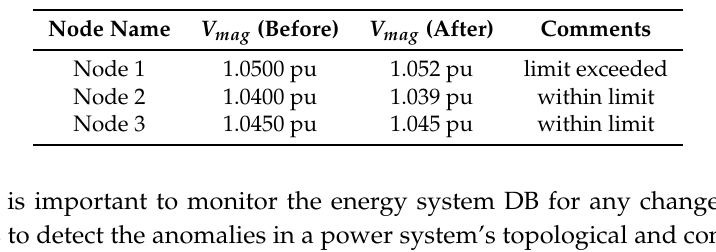
Table 1. Node voltages before and after DB manipulation.